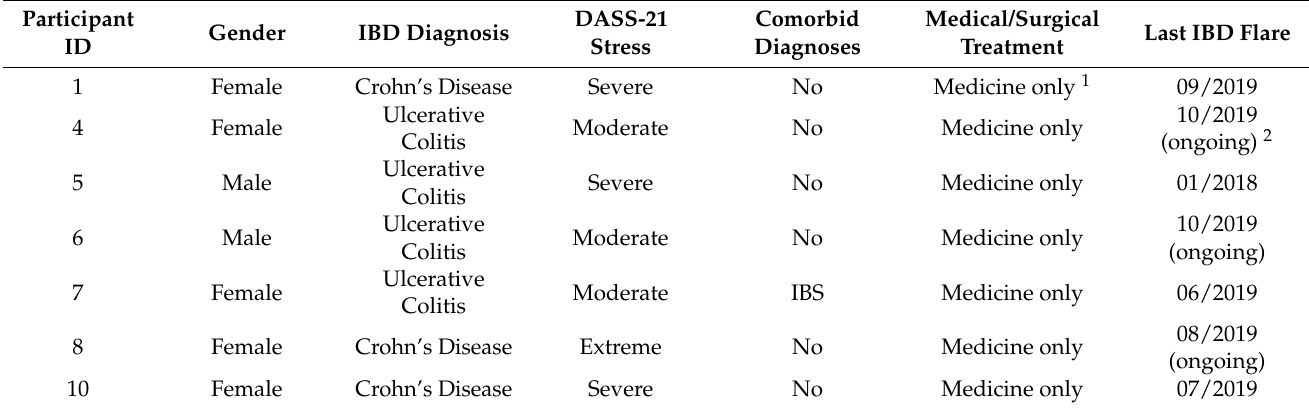
Table 1. Participant gender, IBD diagnosis, and DASS-measured stress at study